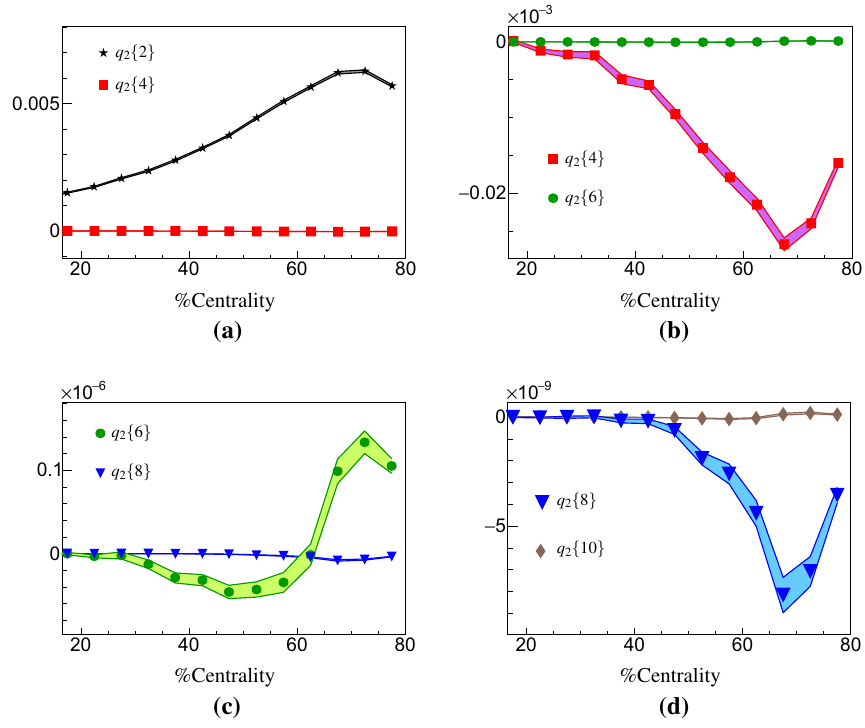
Fig. 3 The cumulants q 2 { 2 k } obtained from the iEBE-VISHNU event